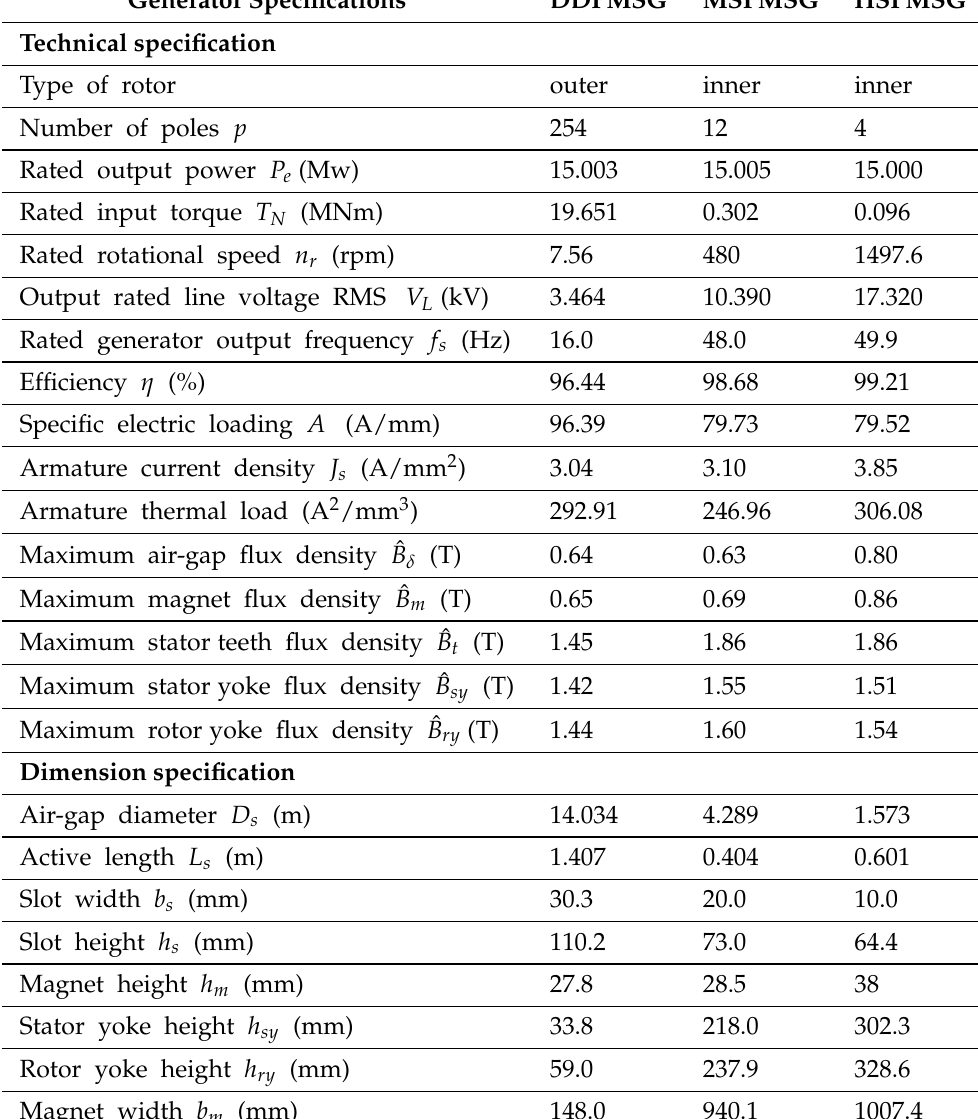
Table 2. Generator design